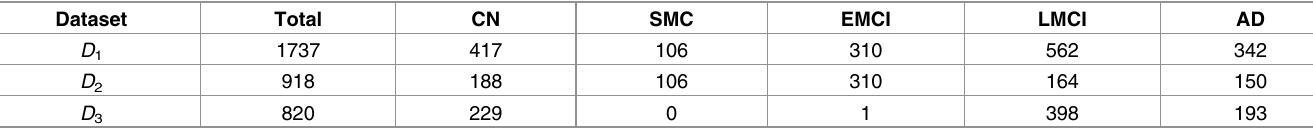
Table 1. The number of subjects contained in datasets D 1 , D 2 and D 3 divided by the level of cognitive impairment.